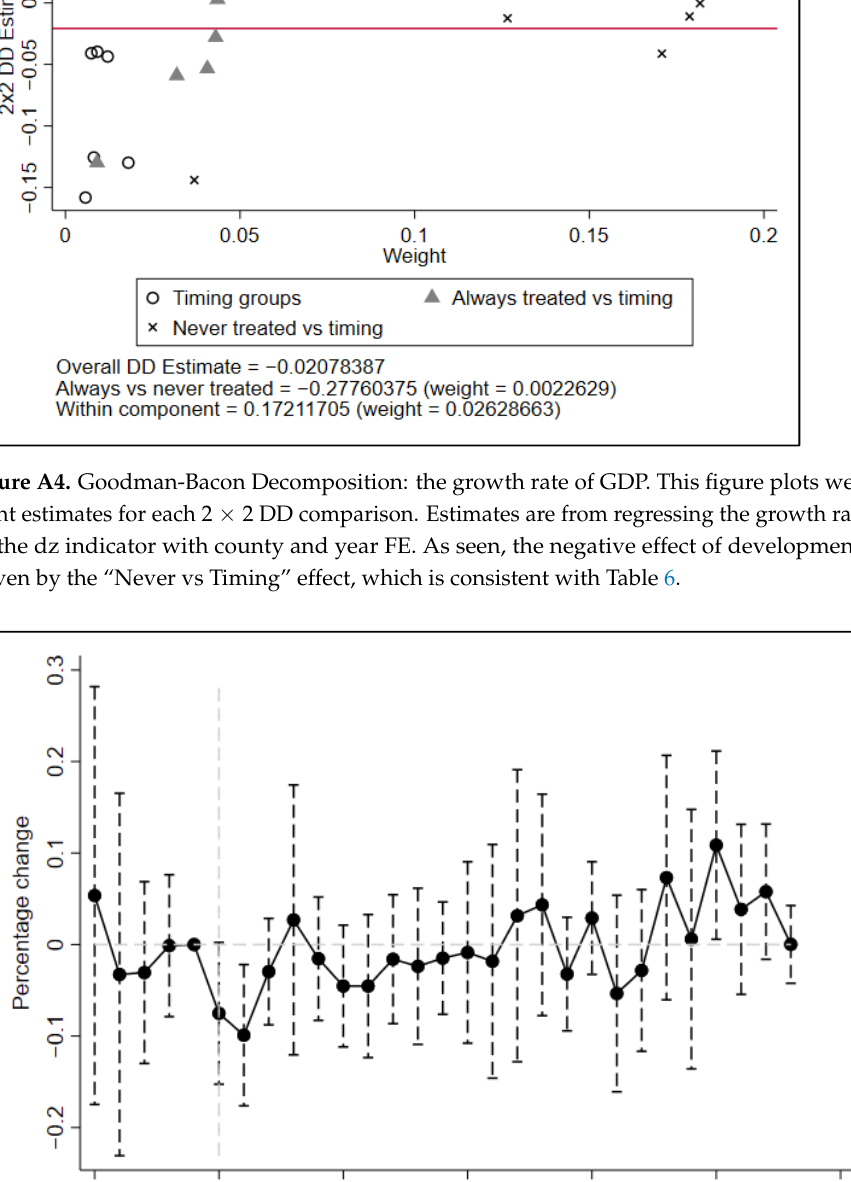
Figure A5. The impact of development zones on local economic growth (gdpg) based on the Inter-